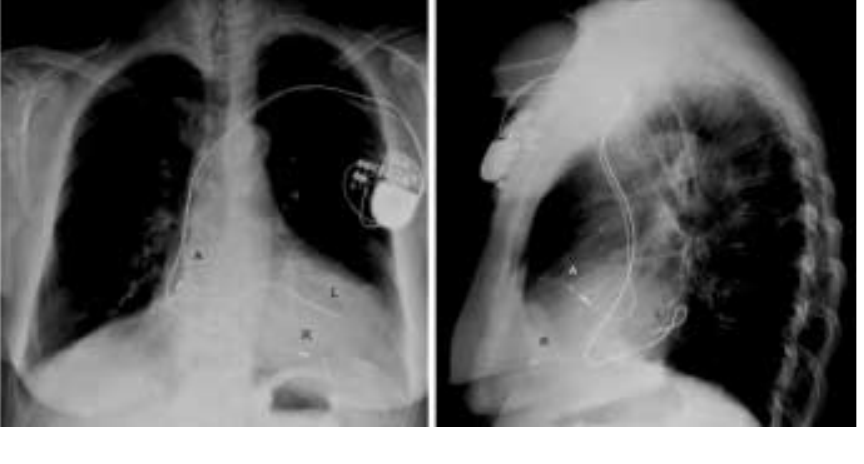
A: Twelve-lead electrocardiogram of a patient with dyspnoea NYHA class IV and 20% left ventricular ejection fraction due to non- ischemic cardiomyo- pathy. The intrinsic heart rate shows broad QRS (226 ms) with a left bundle branch block and an AV block I (192